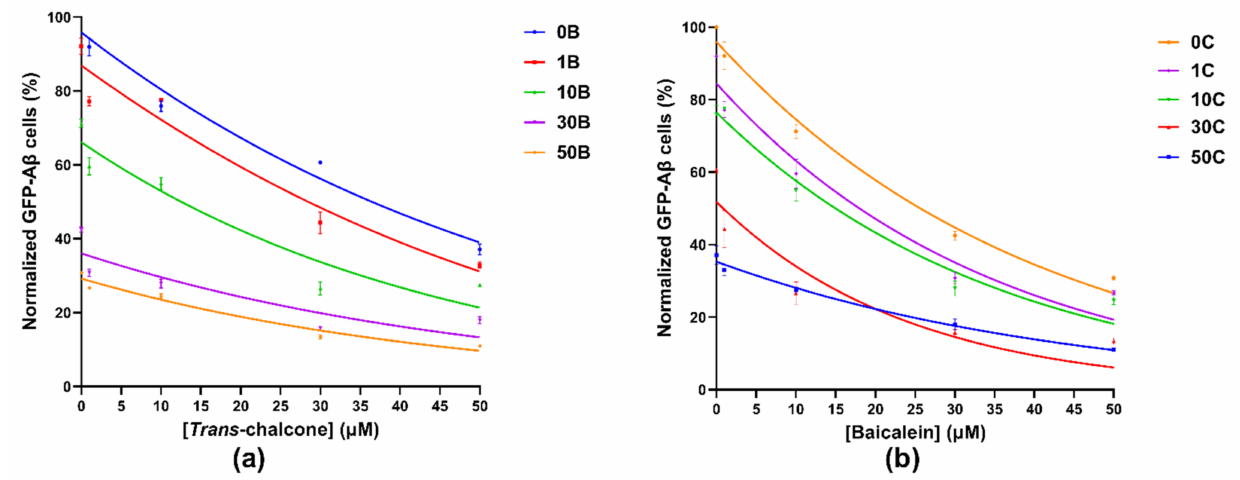
Figure 3. Gaussian curves obtained by plotting the normalized GFP-A β 42 positive cells in percentages when the BY4743 ∆ ahp1 [p416.GPD.GFPA β µ M trans -chalcone with constant 42 ] cells were treated with ( a ) combinations of 0, 1, 10, 30 and 50 concentrations of baicalein at 0, 1, 10, 30 and 50 µ M represented by curves 0B, 1B, 10B, 30B and 50B, respectively, and ( b ) combinations of 0, 1, 10, 30 and 50 µ M baicalein with constant concentrations of trans -chalcone at 0, 1, 10, 30 and 50 µ M represented by curves 0C, 1C, 10C, 30C and 50C, respectively. The total GFP-A β 42 producing cells in the untreated control were normalized to 100% and used for comparison with the treated